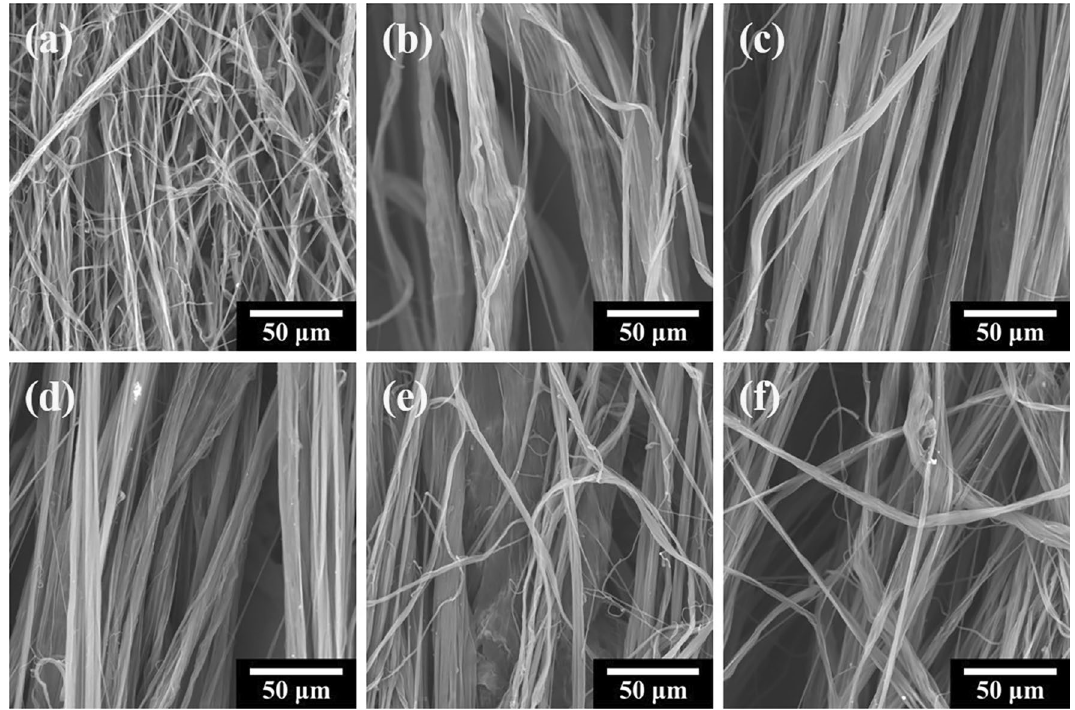
Figure 3. Scanning electron microscope images of FSFs obtained at different PSP values. Images corresponding to ( a ) PSP-134, ( b ) PSP-113, ( c ) PSP-87, ( d ) PSP-76, ( e ) PSP-69, and ( f ) PSP-65.